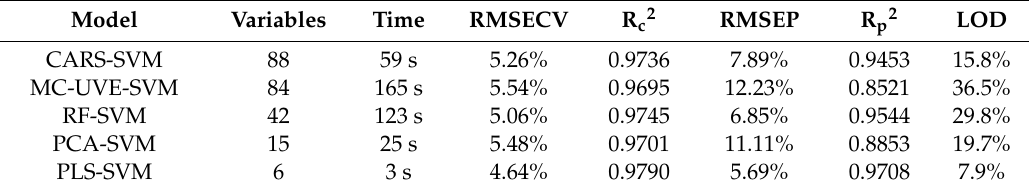
Table 3. Comparison of SVM models based on di ff erent variable selection methods.